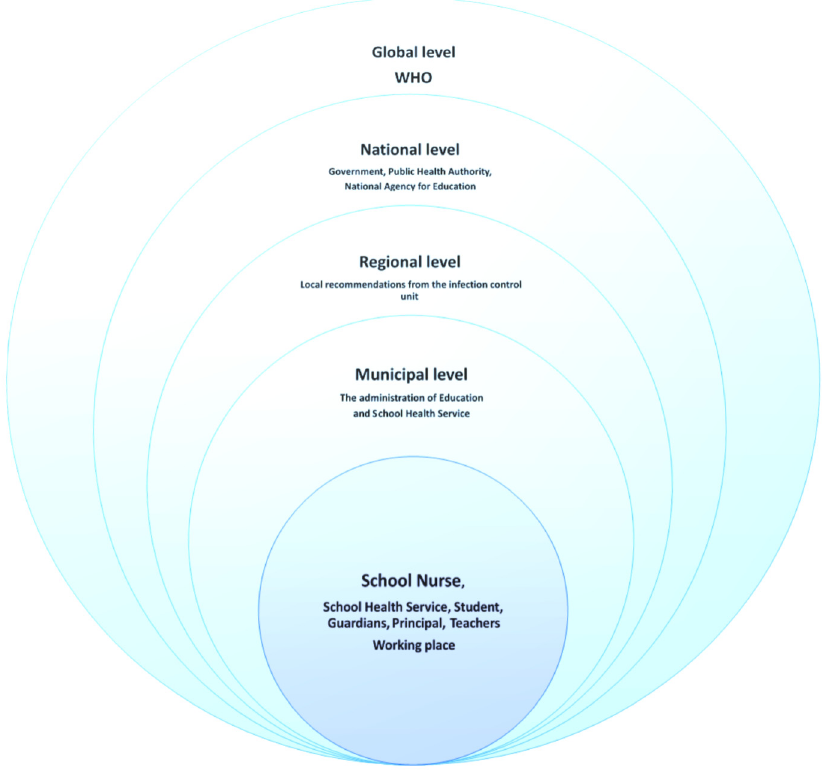
Figure 2. The school nurse’s work and decision-making levels, which affect work during the pan- demic.